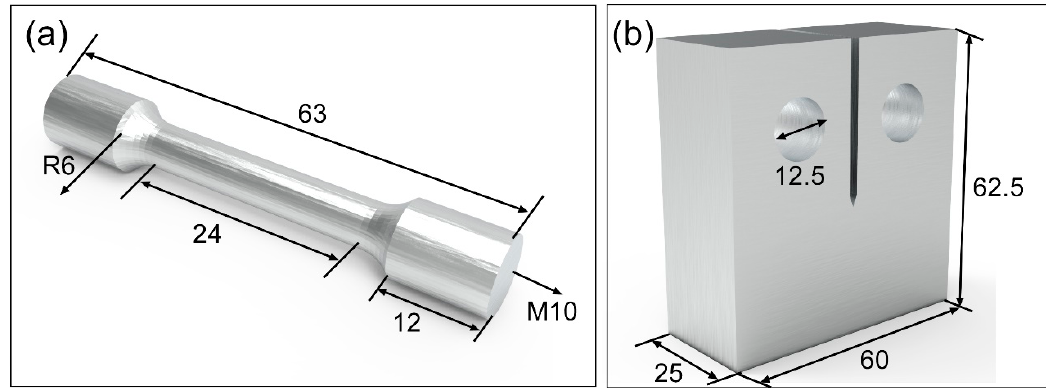
Figure 3. Schematic of ( a ) standard M10 cylindrical tension test samples and ( b ) dimension of compact-tension specimen.